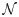
Sinusoidal networks in liver tissue.A. The liver is organized into millimeter-sized lobules, each containing a central vein (CV, cyan) and several portal veins (PV, orange). Blood flows from PV to CV through the plexus-like sinusoidal network. B. Raw sinusoidal network obtained by high-resolution 3D imaging of mouse liver tissue. Shown is the network skeleton with branch points (black) and edges (blue), defining a spatial network. CV and PV shown schematically. Scale bar: 100 μm. C. Sinusoidal network N obtained from the raw network by removal of degree-2 nodes and disconnected components, used in all subsequent analysis, see also S1 Movie for a three-dimensional visualization. D, E, F. Distribution of node degree p(k), distribution of edge lengths p(l), and radial distribution function g(r) of spatial node positions for the sinusoidal network N, respectively. G. The majority of edges of the sinusoidal network are contained in the Delaunay graph corresponding to its set of node positions. Edges of the sinusoidal network not contained in the Delaunay graph are shown in red. Inset: cartoon illustrating a Delaunay graph (black) and Voronoi tessellation (gray) of a set of points. H. The sinusoidal network contains the majority of edges of the minimum spanning tree M(P) of its set of node positions P. Edges of M(P) not in E are shown in red. Inset: cartoon representation of a minimum spanning tree (green).